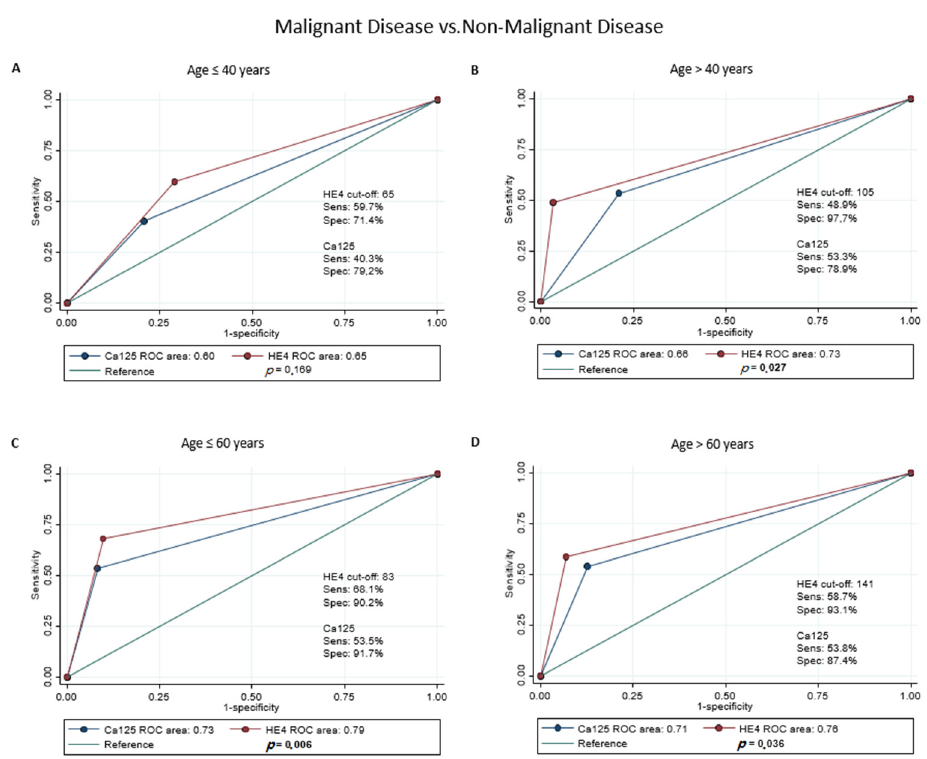
Figure 2. ROC regression analysis of HE4 and Ca125 values in malignant disease vs. non-malignant disease. Population has been stratified as follows: Premenopausal status: ≤ 40 years ( A ), >40 years ( B ); postmenopausal status: ≤ 60 years ( C ) and >60 years ( D ).